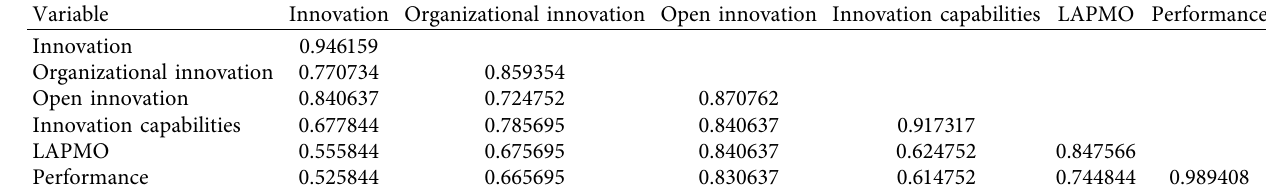
Table 7: Divergent reliability of the model (made by